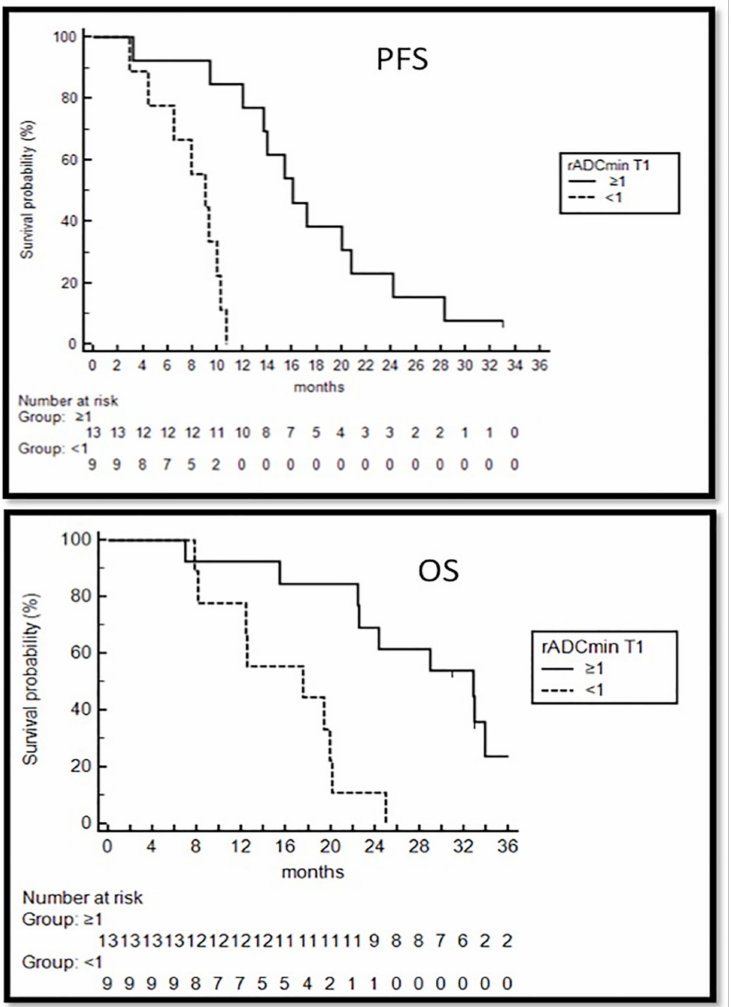
Figure 4. Survival analysis. Kaplan Meier curves showing progression free survival (PFS) and overall survival (OS) of patients with ADC ≥ 1 or ADC < 1 in the tumor at pre-vaccine